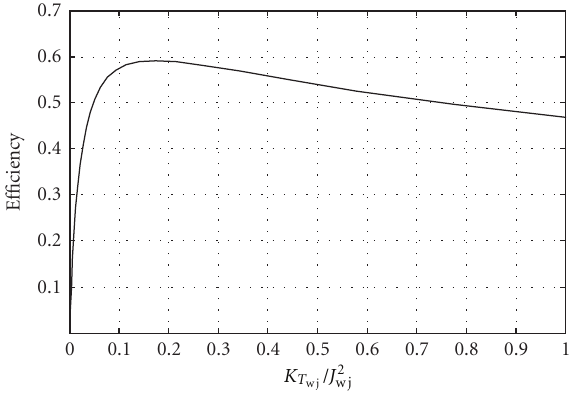
Figure 13: Waterjet e ffi ciency versus K T